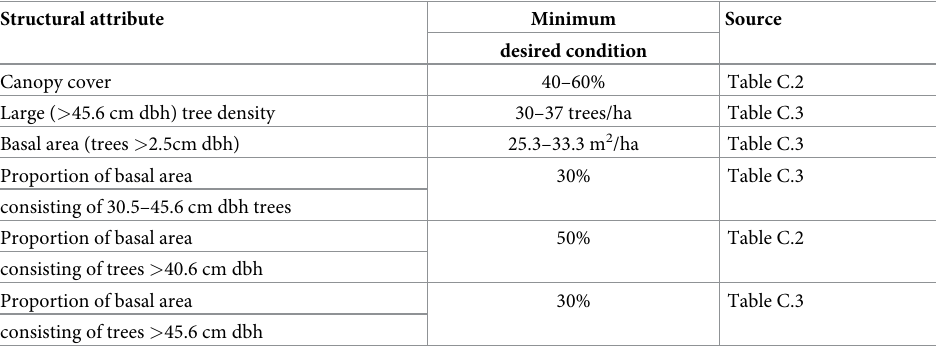
Table 1. Desired minimum conditions for six structural attributes of Mexican spotted owl nesting/roosting